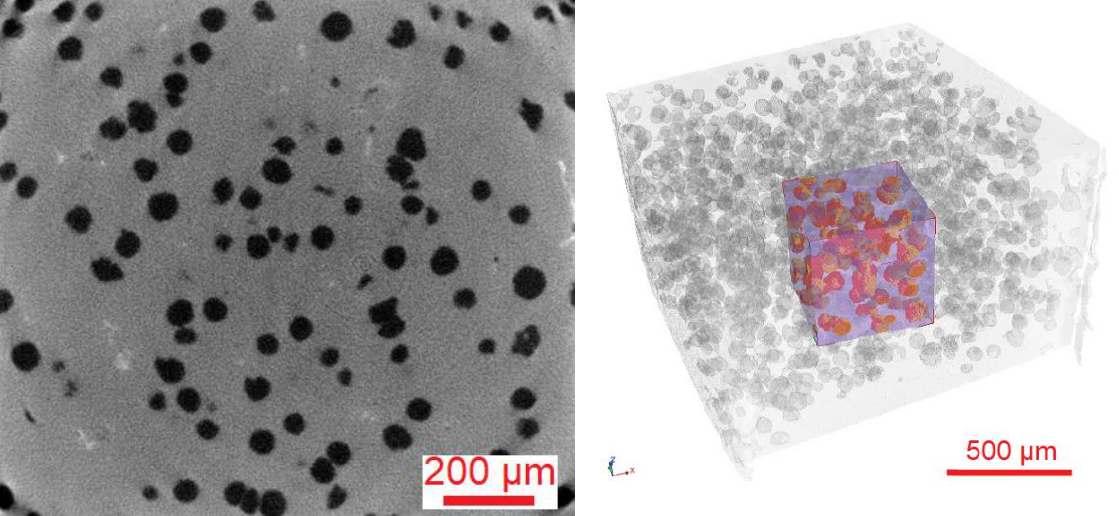
Figure 1. Tomogram showing the microstructure with spheroidal graphite and 3D reconstruction of the sample with the analyzed area.